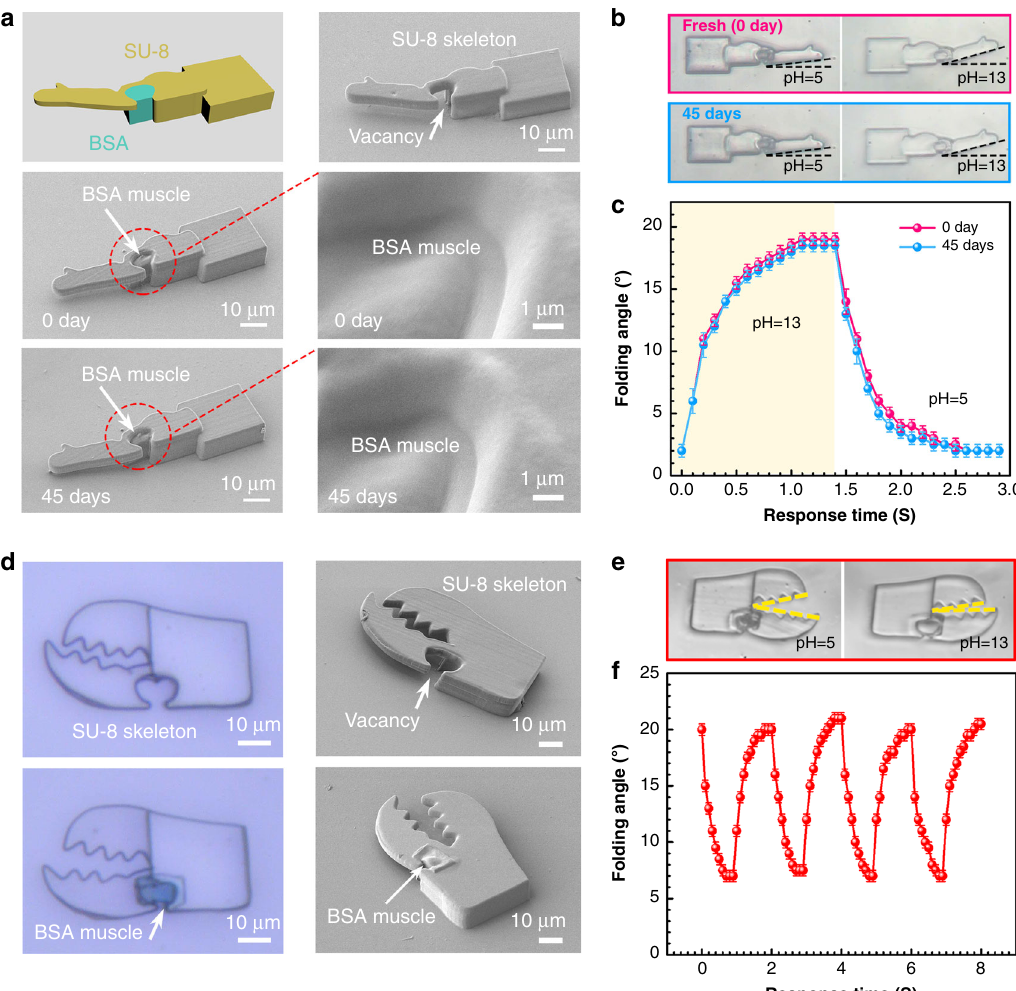
Fig. 3 Dynamic pH actuation of two typical musculoskeletal systems. a Arm-muscle system: Top images: the model (left) and SEM image (right) of the SU-8 skeleton. Middle images: SEM image (left) of the arm-muscle after BSA integration and SEM image of the BSA and SU-8 interface (right). Bottom images: SEM images of the arm-muscle (left) and the two materials interface (right) after storage for 45 days. b Optical microscopic images of the pH actuation of the arm-muscle and that after 45 days. c Dynamic pH-responsive properties of the arm-muscle structure. d The crab claw-muscle system: Top images: Optical microscopic image (left) and SEM image of the SU-8 skeleton (right); bottom images: Optical microscopic image (left) and SEM image of the claw after BSA integration (right). e Optical microscopic images of the pH actuation of the claw. f Dynamic pH-responsive properties of the crab claw for 4 cycles. Error bars denote the standard deviation of the measurements. Source data are provided as a Source data fi